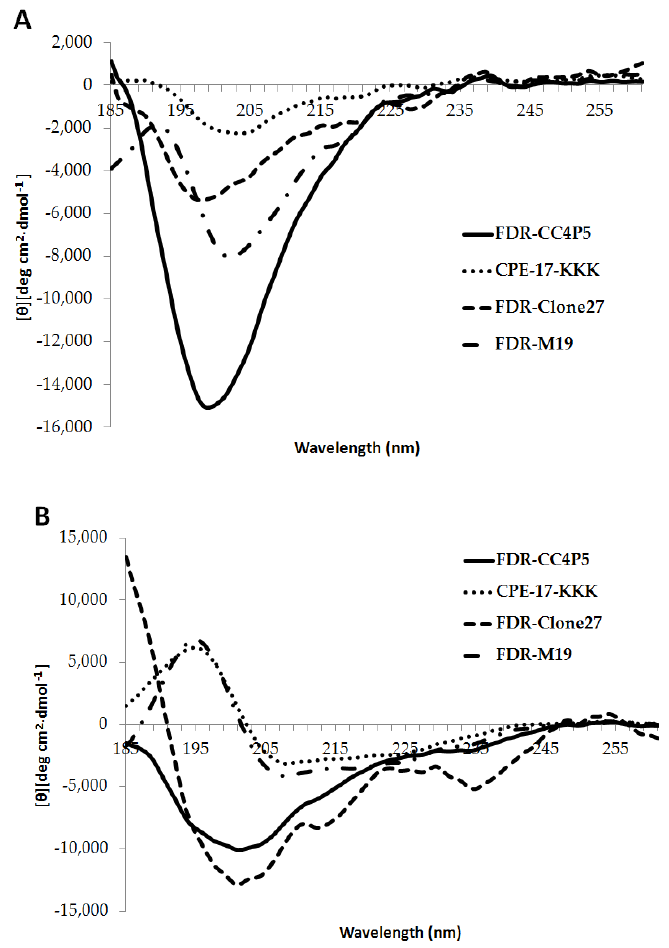
Figure 3. Circular dichroism spectra of the investigated peptides. The spectra were measured at a peptide concentration of 20 μmol·L −1 in 10 mmol·L −1 phosphate buffer ( A ) and 10 mmol·L −1 phosphate buffer with the additon of 50% TFE ( B ).